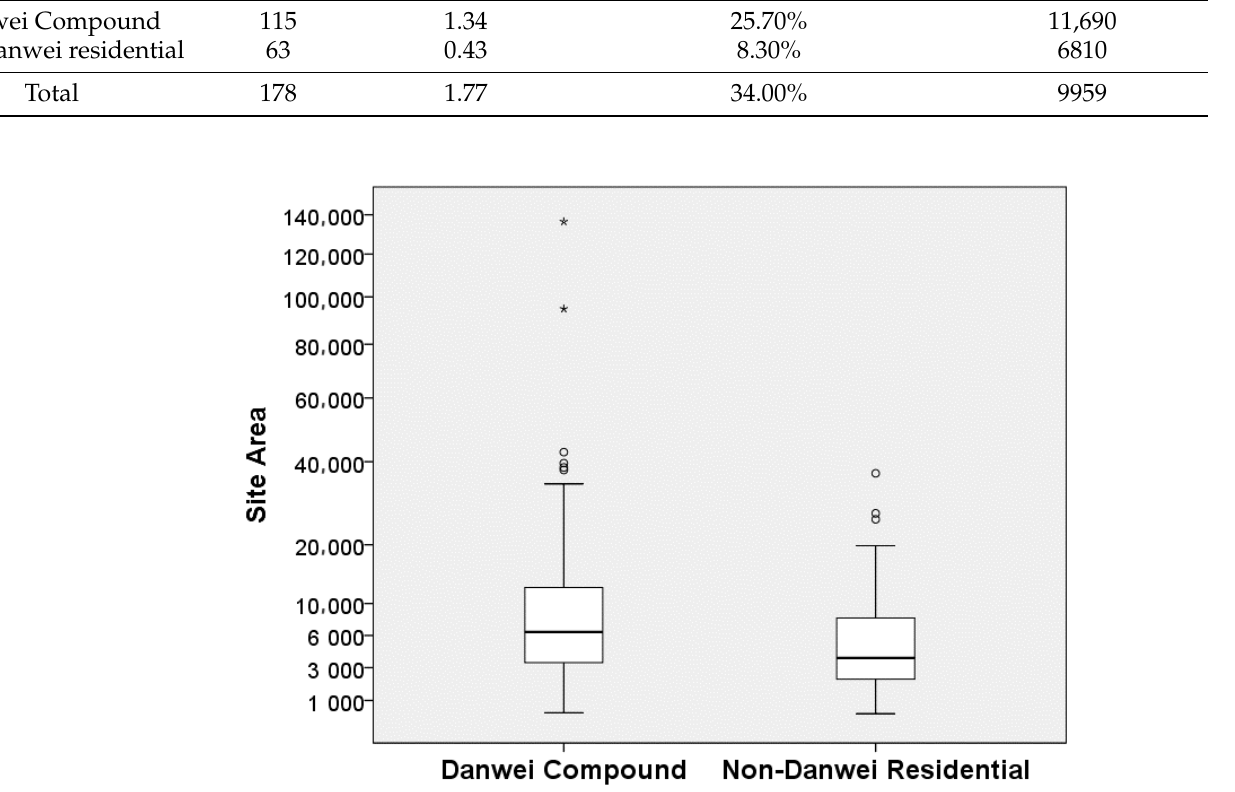
Figure 7. The Site Area box chart by Site Type. Table 2. Key values of Figure